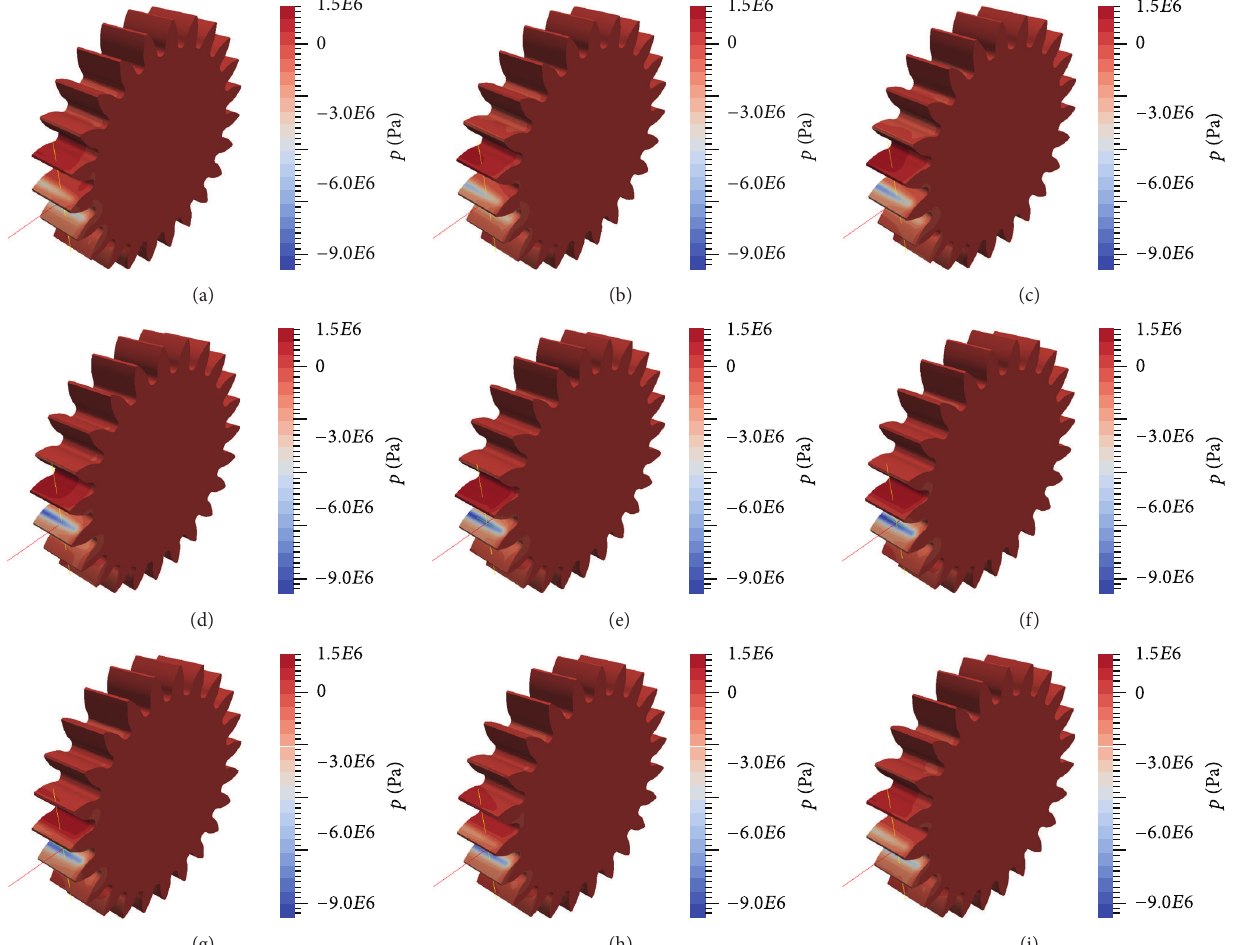
Figure 5: Relative pressure variation in meshing positions